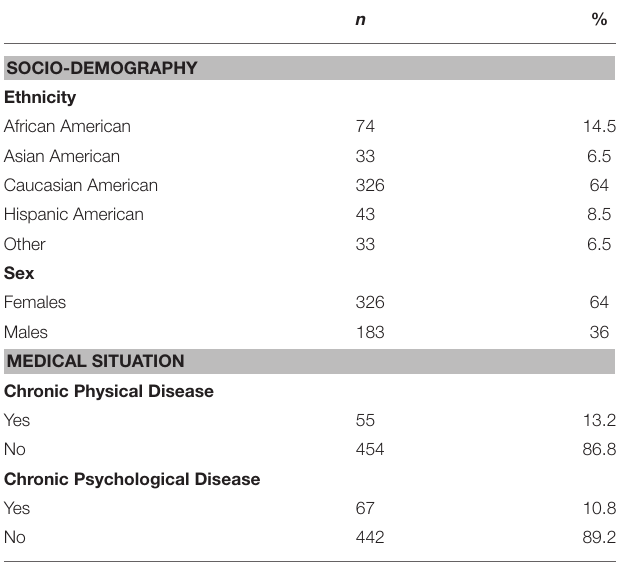
TABLE 1 | Socio-demography and medical situation of